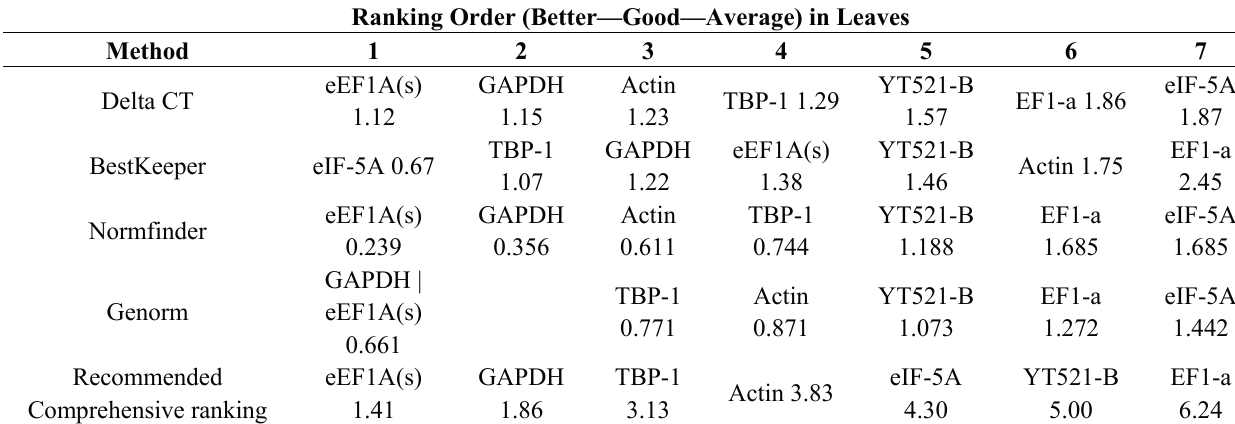
Table 2. Evaluation of the expression stabilities of candidate internal reference genes in leaves of annual